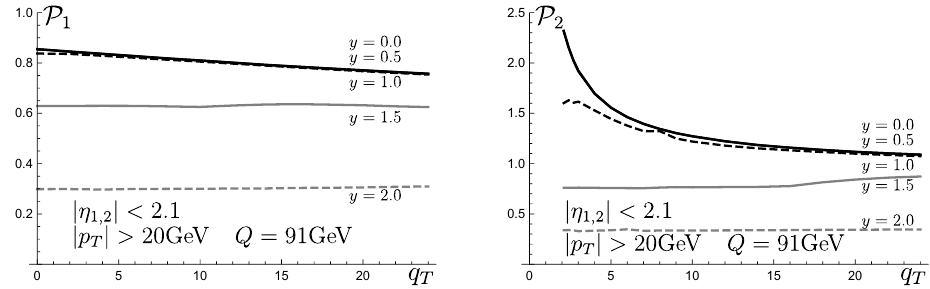
Figure 1 . Plot of cut-factors P 1 ; 2 (2.57), (2.58) versus q T [GeV] in the case of (cid:12)ducial cuts of ATLAS and CMS Z-boson measurement [47{50], at Q = 91 : GeV and di(cid:11)erent values of y . The lines with y = 0 : 0 and y = 0 : 5 are very close to each